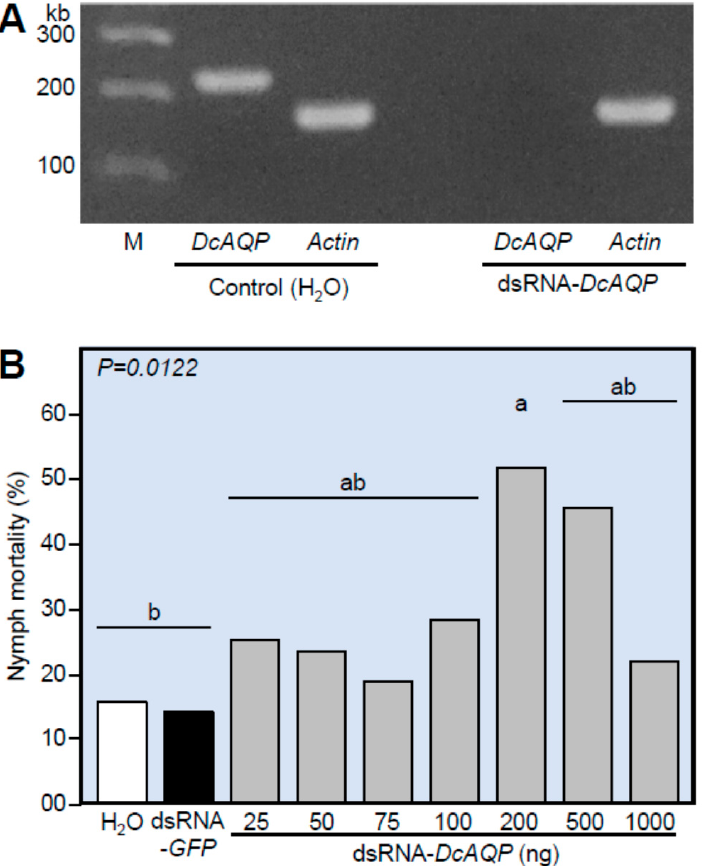
Figure 4. Effect of DcAQP silencing on the expression of DcAQP and the mortality of D. citri nymphs. ( A ) Semi-quantification of DcAQP after the treatment with 500 ng of dsRNA- DcAQP . Total RNAs were extracted using TRIzol ® Reagent from 4th–5th nymph instars treated twice with dsRNA- DcAQP in comparison with H 2 O as a control. After amplification, transcript levels of DcAQP were semi-quantified on a 1.5% agarose gel. Actin was used as an internal control gene. ( B ) Mortality (%) of 4th–5th nymph instars of D. citri treated twice with different concentrations of dsRNA- DcAQP (25, 50, 75, 100, 200, 500 and 1000 ng · µ L − 1 ) in comparison with RNase-free water and dsRNA- GFP as controls. Bars and error bars represent means and SDs, respectively. Different letters indicate statistically significant differences among treatments, while the same letter signifies no significant differences among treatments using Tukey HSD ( p < 0.05 ).